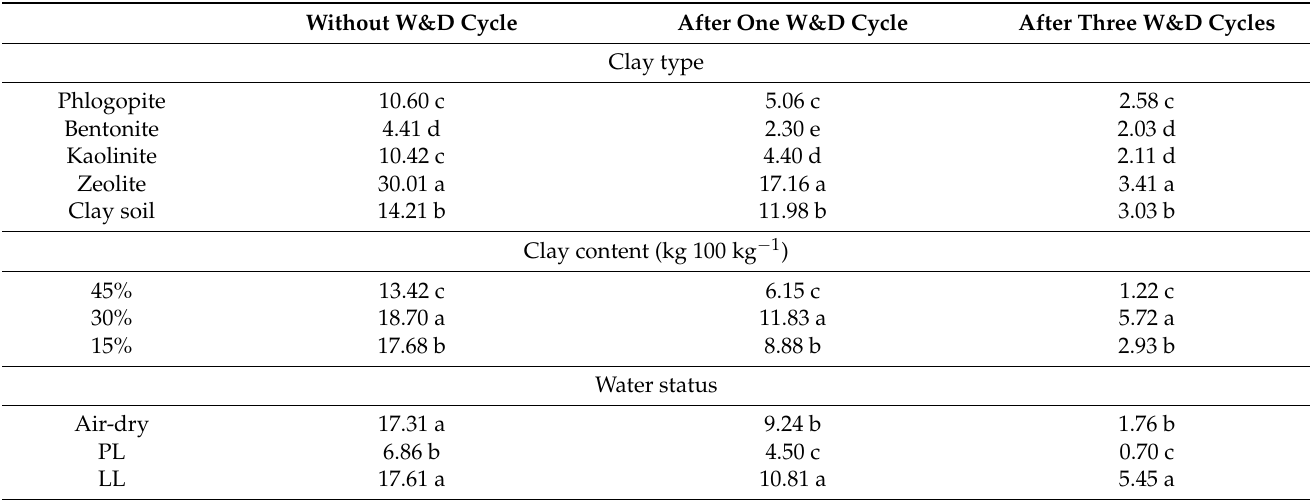
Table 5. Comparisons of the mean effects of treatments on the splash erosion (g m − 2 min − 1 ) of the studied clay–sand mixtures and clay soil. Without W&D Cycle After One W&D Cycle After Three W&D Cycles Clay